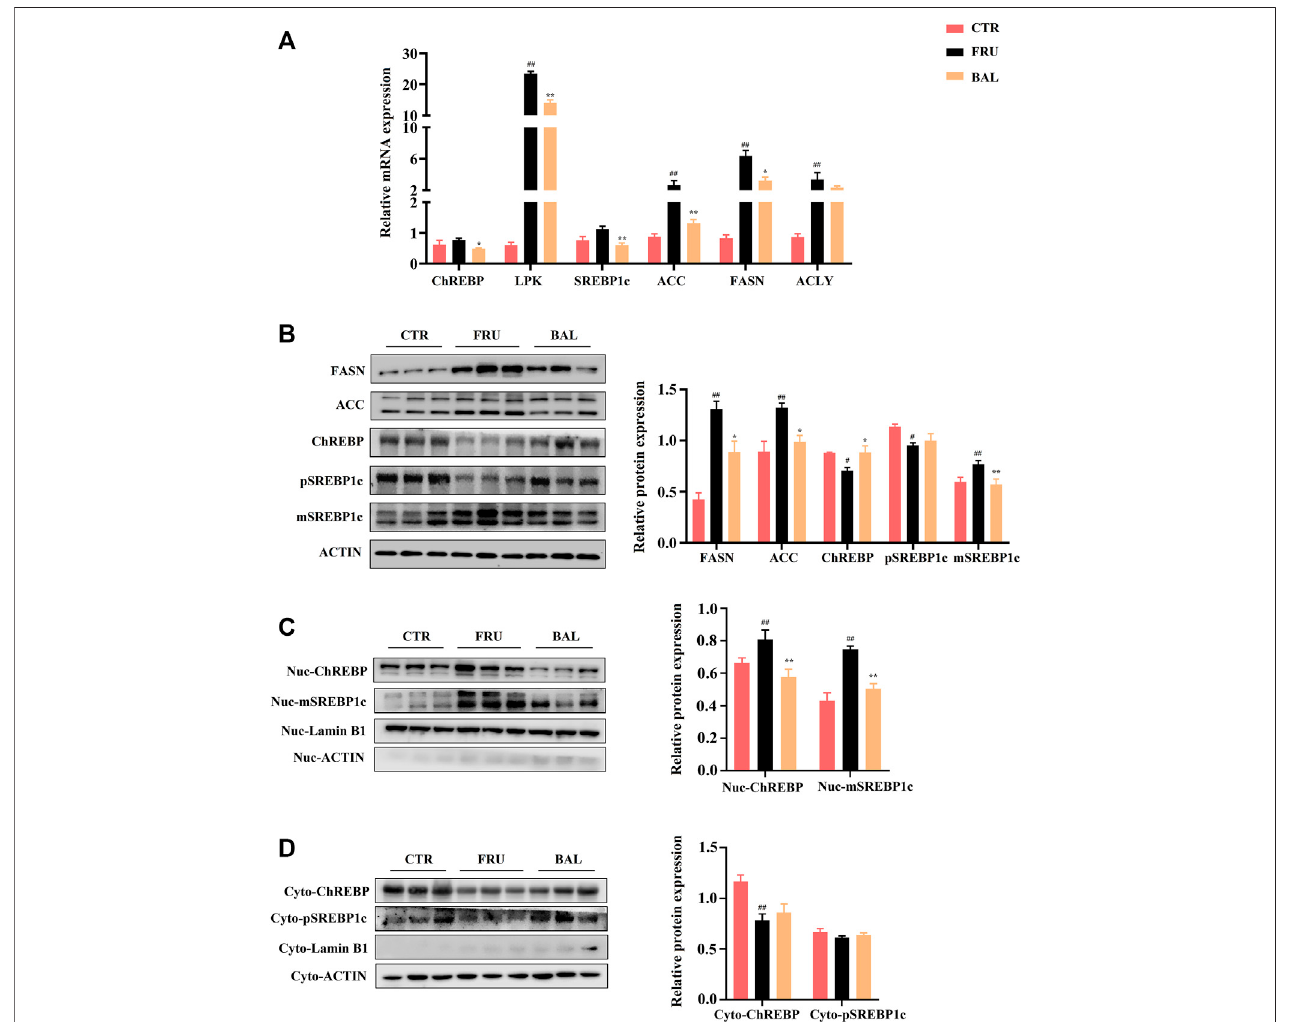
FIGURE6| EffectsofkeymoleculesonChREBP1/SREBP1c-mediatedDNLpathwaybyBALtreatment. (A) TherelatedgenesexpressionsbyRT-qPCRanalysis. (B) Expressions of proteins in liver tissue. (C) The nuclear proteins expressions in liver. (D) Proteins expressions in cytoplasm of rat liver. Data were represented as Mean ± SEM ( n = 6/group), ## p < 0.01 , # p < 0.05 , compared with CTR; **p < 0.01 , *p < 0.05 , compared to FRU.